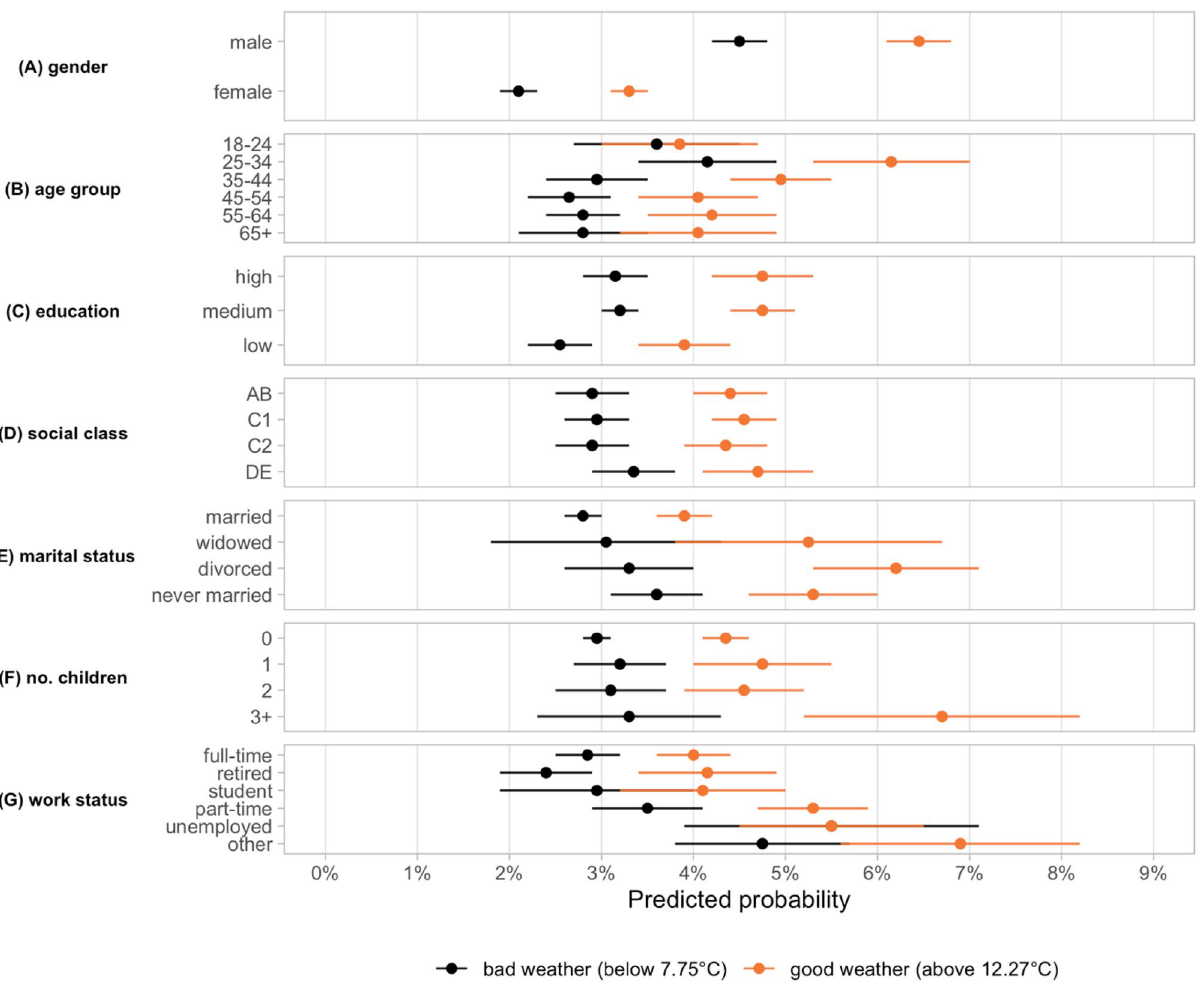
Figure 3. Warmer temperature had a large effect on non-compliance behavior with certain demographic and socio-economic characteristics. The panels show the predicted probability of non-compliance when a given individual level characteristic is equal to 1 while all other covariates are held constant at their mean values. The black (orange) dots are estimates based on observations under bad (good) weather conditions, where good and bad weather are defined by the top and bottom quartiles (12.27 °C and 7.75 °C , respectively) of temperature. The estimates are based on a logistic regression with date and region fixed effects included and robust standard errors clustered at the region level. The horizontal lines show the 95% confidence intervals. N =